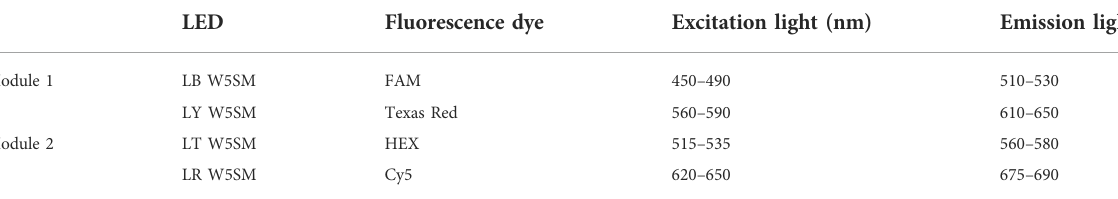
TABLE 1 Fluorescence dyes excitation and emission wavelengths.